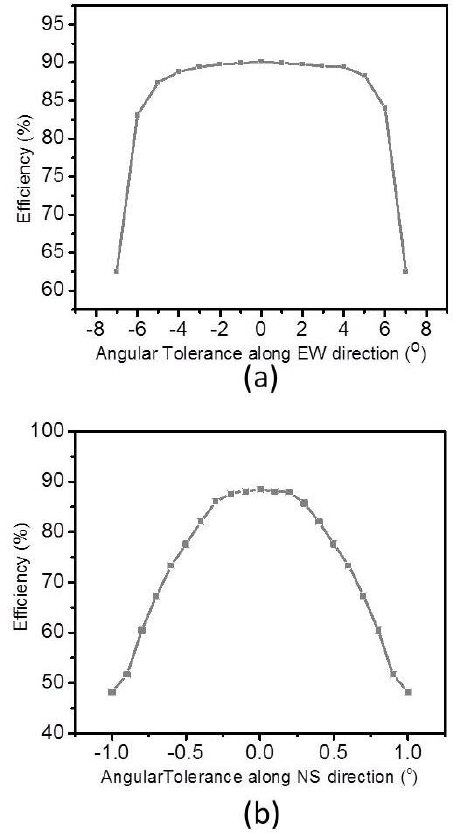
Figure 12. Variation of optical efficiency of the concentrator at different angular deviations along the ( a ) EW direction; and ( b ) NS direction.